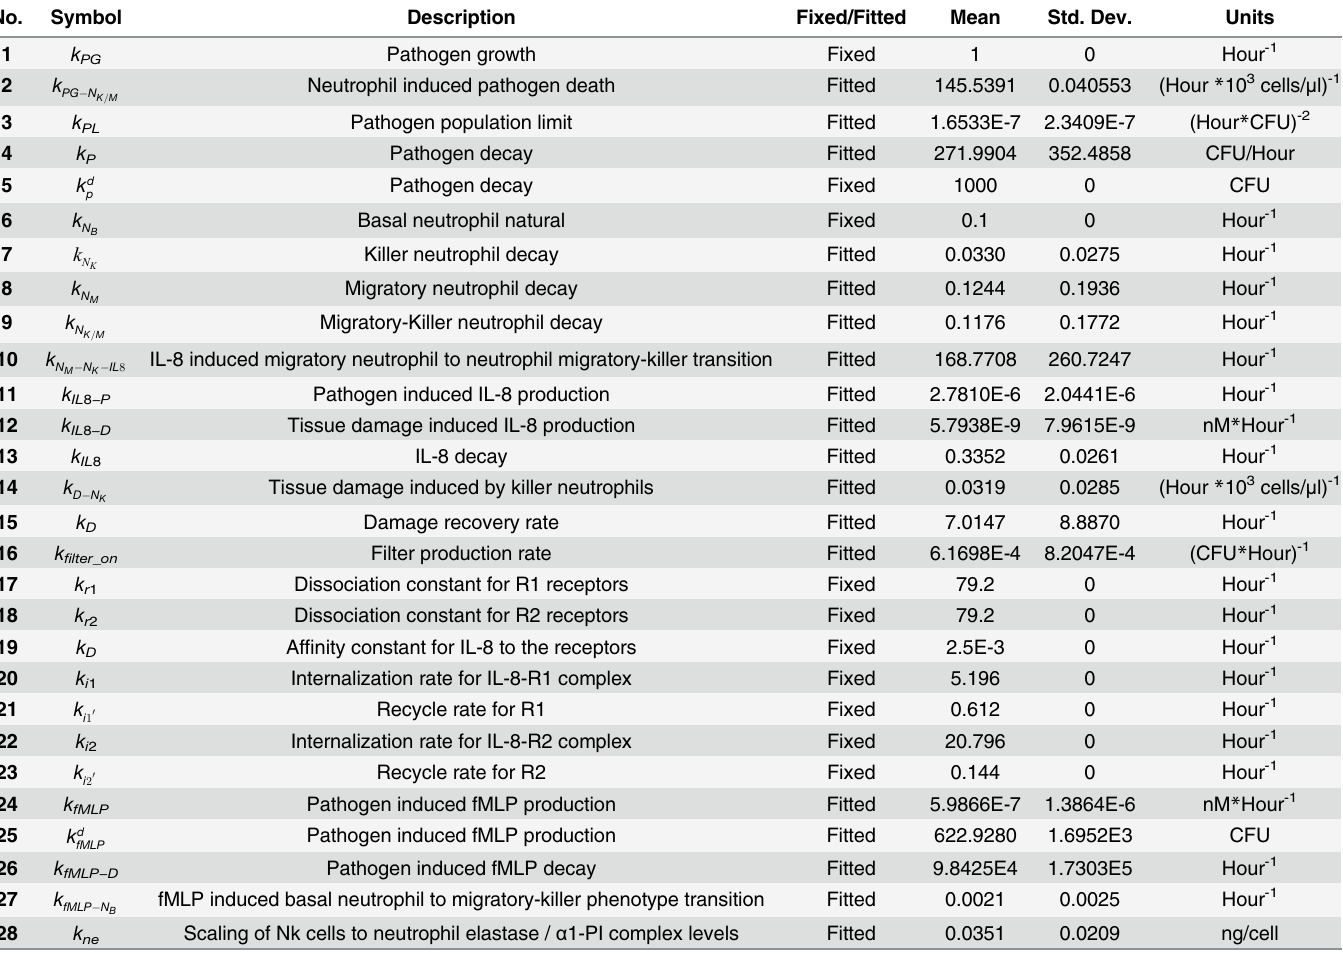
Table 2. Shared parameter